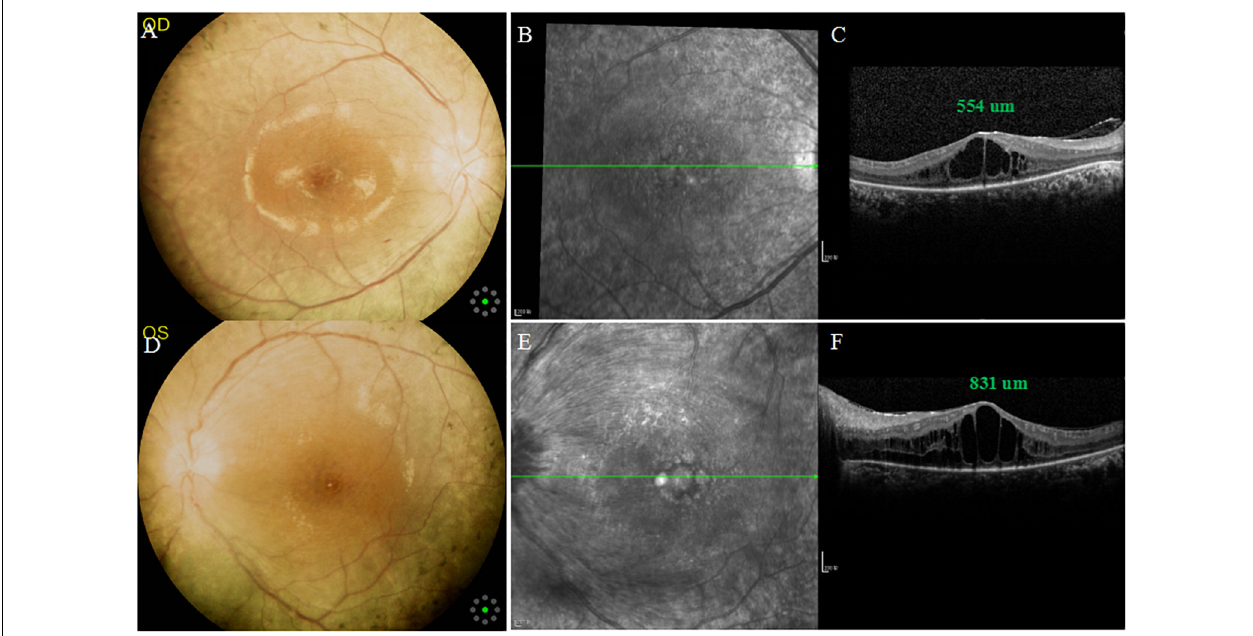
FIGURE 1 | Multimodal imaging of both eyes at the initial examination. (A,D) Color fundus photographs showing arteriolar narrowing, cystoid macular edema (CME) and mid-peripheral bone-spicule-like pigmentations in both eyes, and tortuous and dilated superior temporal vein in the left eye. (B,E) Infrared fundus photographs showing CME in both eyes, and swelling of retinal nerve fiber layer in the left eye. (C,F) SD-OCT: central macular thickness (CMT) was 554 µ m in the right eye and 831 um in the left eye.